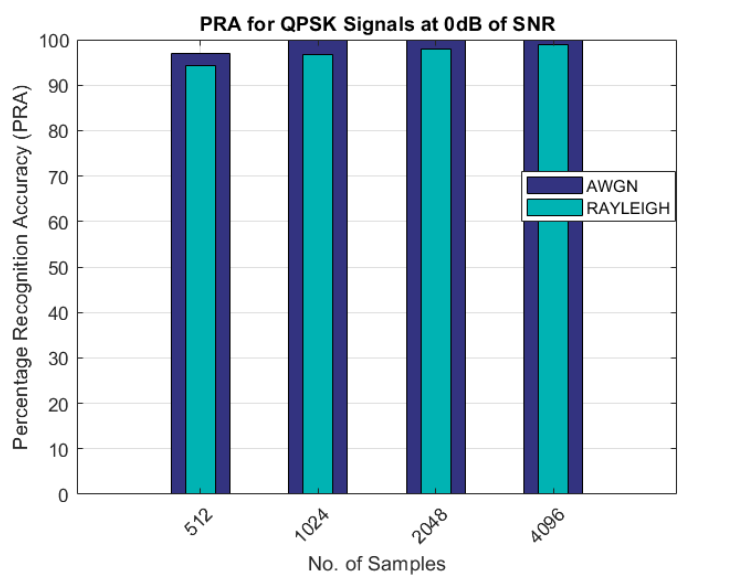
Figure 4. PRA for QPSK